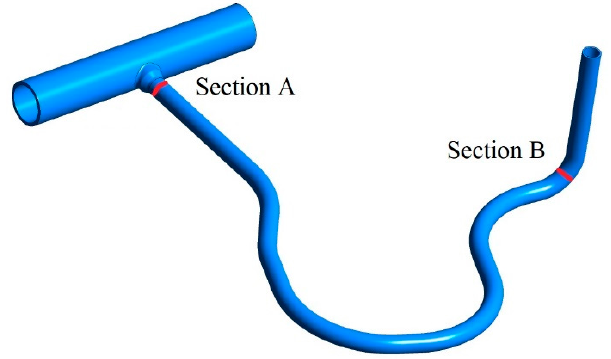
Figure 9. The location of the fatigue evaluation sections.